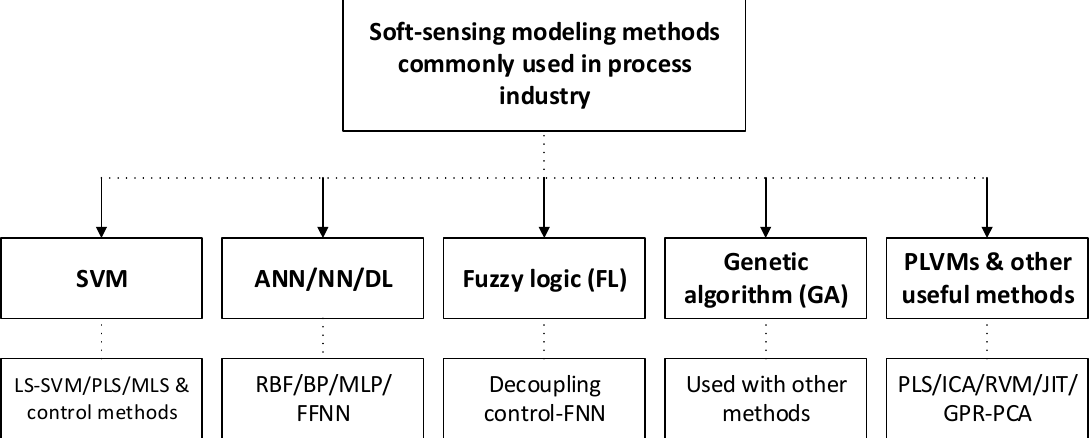
Figure 4. Soft-sensing models used in process industry (abbreviations used are listed in Table A1).